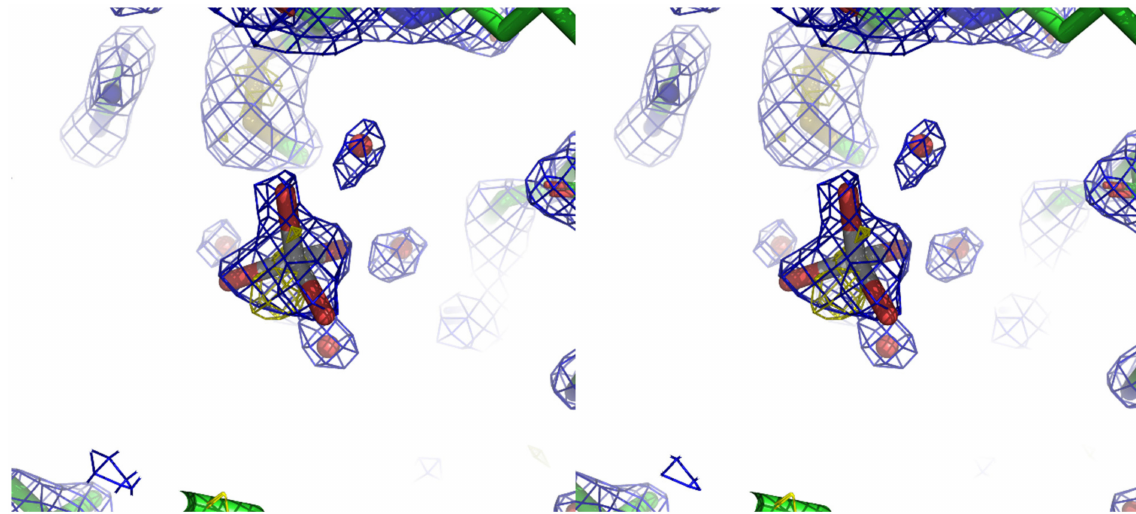
Figure 1. Cross-eye stereo representation of the electron density detail of the mononuclear titanium species and its environment. Water molecules are represented as red spheres. In blue is the 2F o -F c contoured at 1.2 σ level, and in yellow is the anomalous difference map contoured at 3.0 σ value.